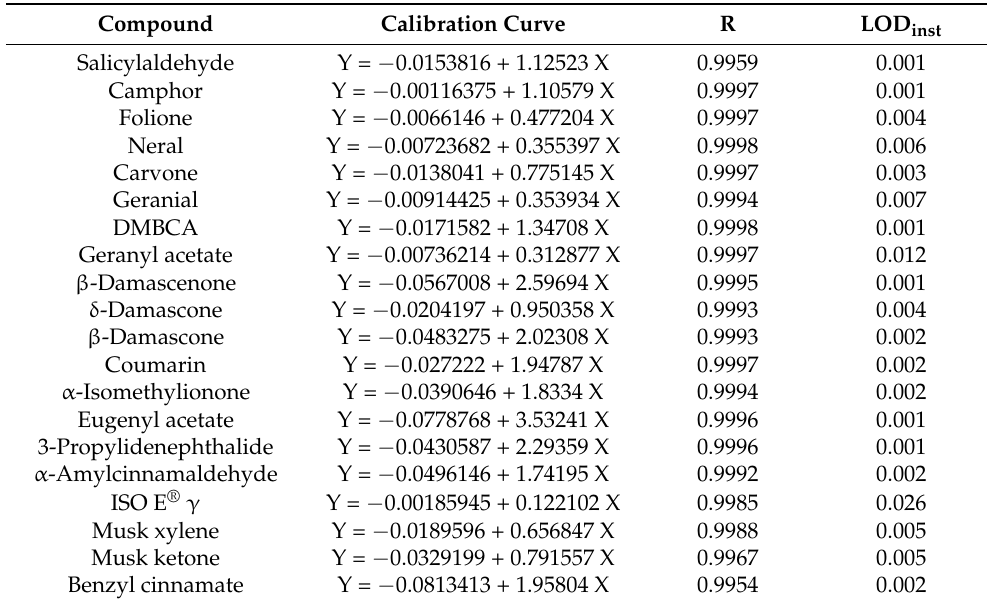
Table 2. Calibration curves, curve correlation coefficient R, and instrumental LOD of selected fragrances.